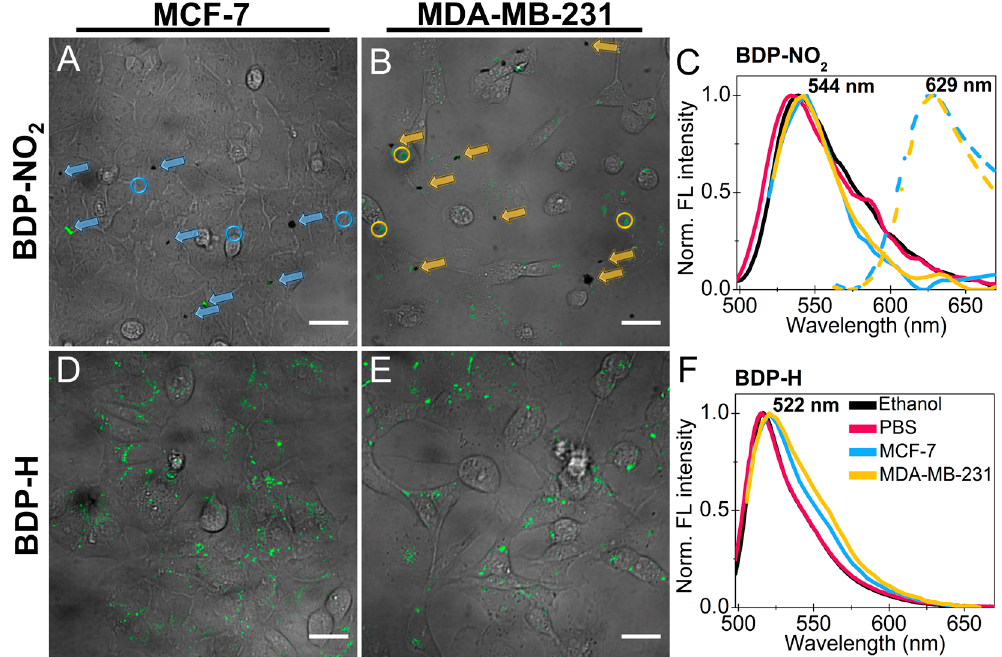
Figure 3. Comparison of BDP-NO 2 and BDP-H staining ( A , B , D , E ) and fluorescence (FL) spectra ( C , F ) in live MCF-7 and MDA-MB-231 cancer cells. ( A , B ) brightfield images merged with fluorescence (FL) images of cancer cells stained with BDP-NO 2 diluted in PBS; scale bars: 30 µm. Blue and yellow arrows mark BDP-NO 2 aggregates and circles denote the spots within which FL spectra of BDP-NO 2 were measured with a 32-channel spectral detector. ( C ) comparison of BDP-NO 2 diluted in ethanol (black) or PBS (red) FL spectra and FL spectra of the molecular rotor from live MCF-7 (blue) and MDA-MB-231 (yellow) cells (all spectra in solid lines). Dashed lines were obtained from BDP-NO 2 aggregates marked with arrows in A and B; λ ex = 480 ± 5 nm. ( D , E ) brightfield images merged with FL images of cancer cells stained with BDP-H diluted in PBS; scale bars: 30 µm. ( F ) comparison of BDP-H diluted in ethanol (black) or PBS (red) FL spectra and FL spectra of the molecular rotor from live MCF-7 (blue) and MDA-MB-231 (yellow) cells; λ ex = 480 ± 5 nm. Blue and yellow FL spectra in F were obtained by averaging FL spectra from 10 different spots within cells, where BDP-H is accumulated, and subtracting the background FL spectra, averaged from 5 different points.